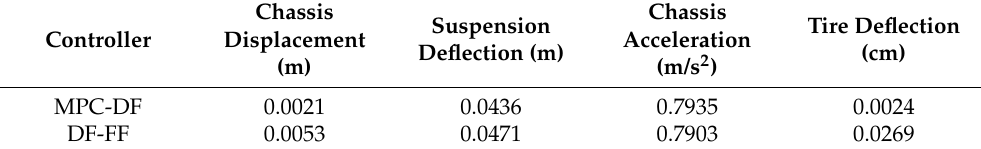
Table 3. RMS Value